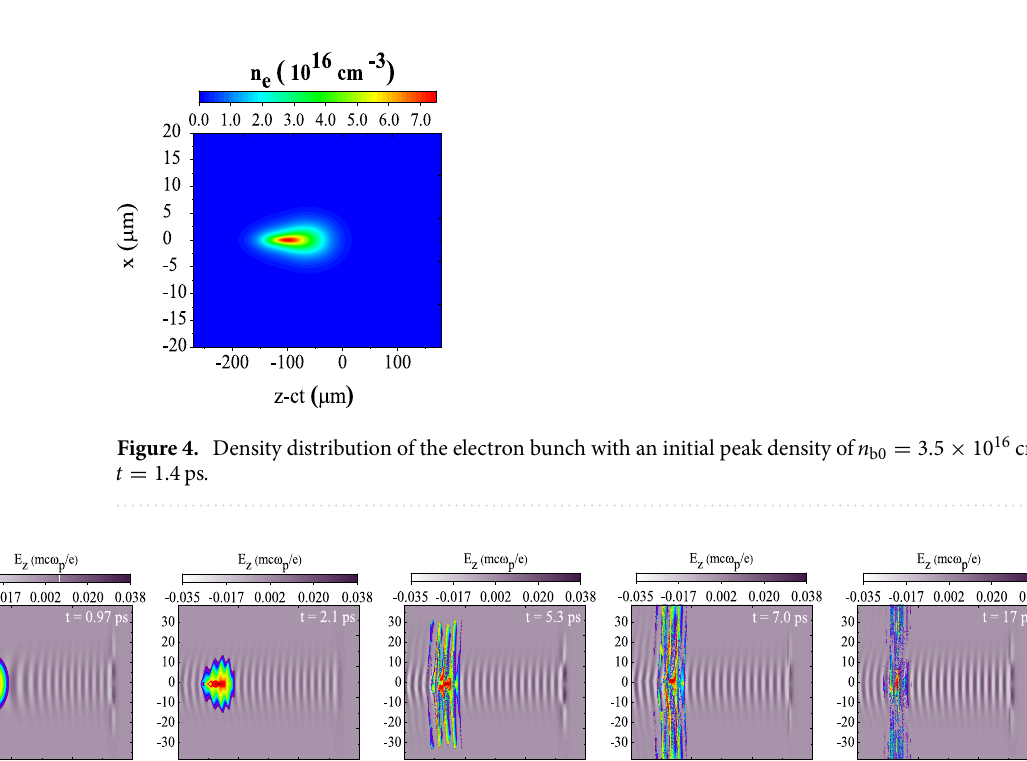
30 ) as a function of =